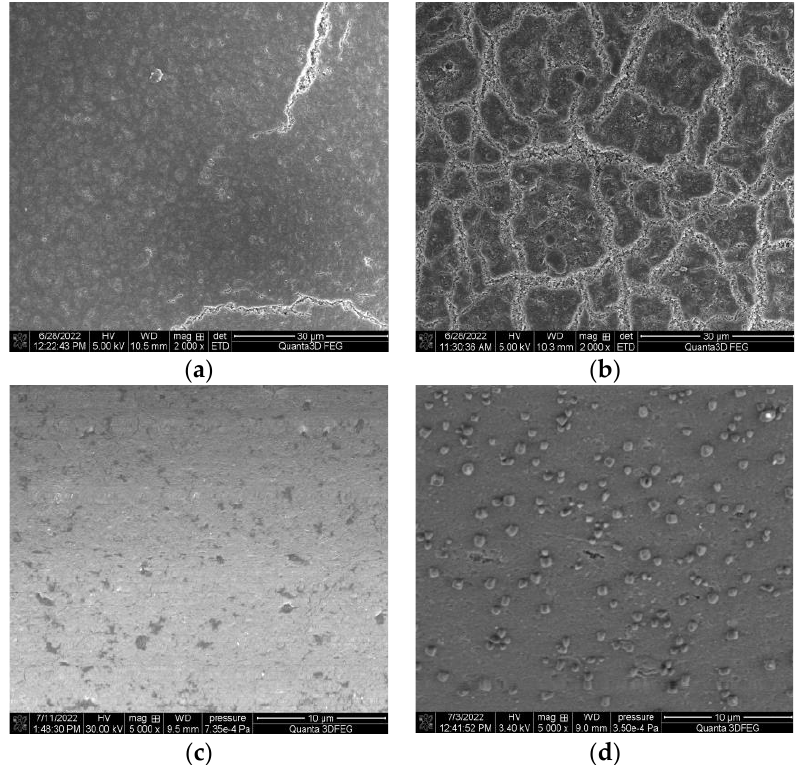
Figure 7. SEM images: ( a ) Purolite MN 202 before the impregnation process; ( b ) Purolite MN 202 after the impregnation process; ( c ) Purolite MN 202 after the sorption of gold(III) ions; ( d ) Purolite MN 202 impregnated with Cyanex 272 after the sorption of gold(III) ions.